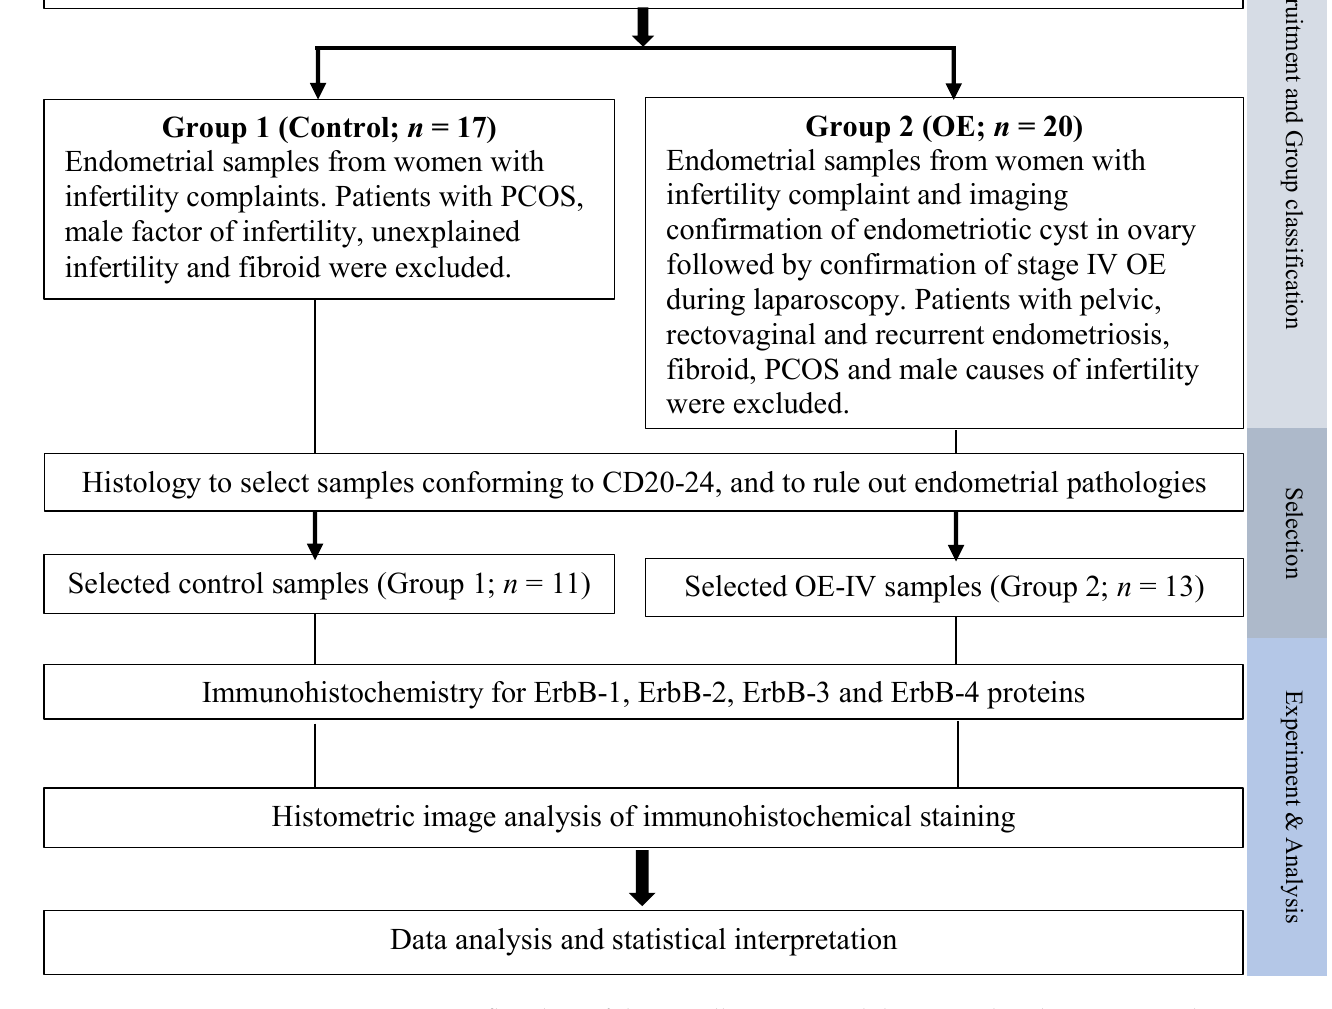
Figure 1. A flowchart of the overall experimental design used in the present study. AMH, anti- Mullerian hormone; CD, cycle day; FSH, follicular stimulating hormone; HSG, hystero-salpingogram; LH, luteinizing hormone; OE, ovarian endometriosis; OE-IV, stage IV ovarian endometriosis; PCOS, polycystic ovarian syndrome; TSH, thyroid-stimulating hormone.